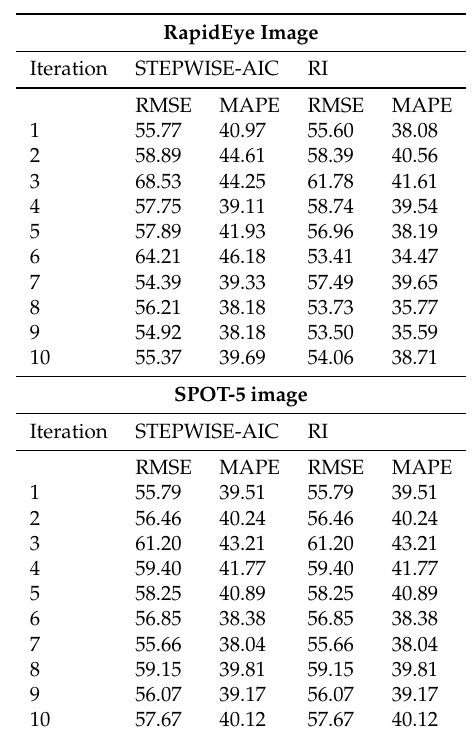
Table 6. Root mean square error (RMSE) and mean absolute percentage error (MAPE) of the triple crossed validation from the regression models by replica for images of RapidEye and